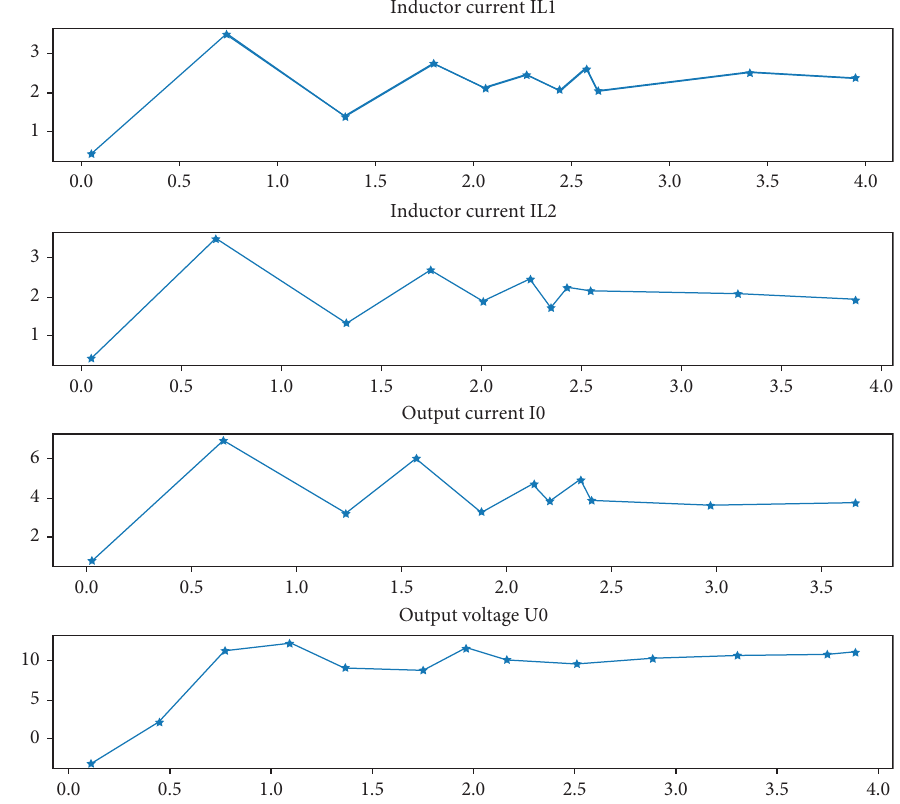
Figure 14: Simulation diagram of inductive current and output voltage current of each circuit.